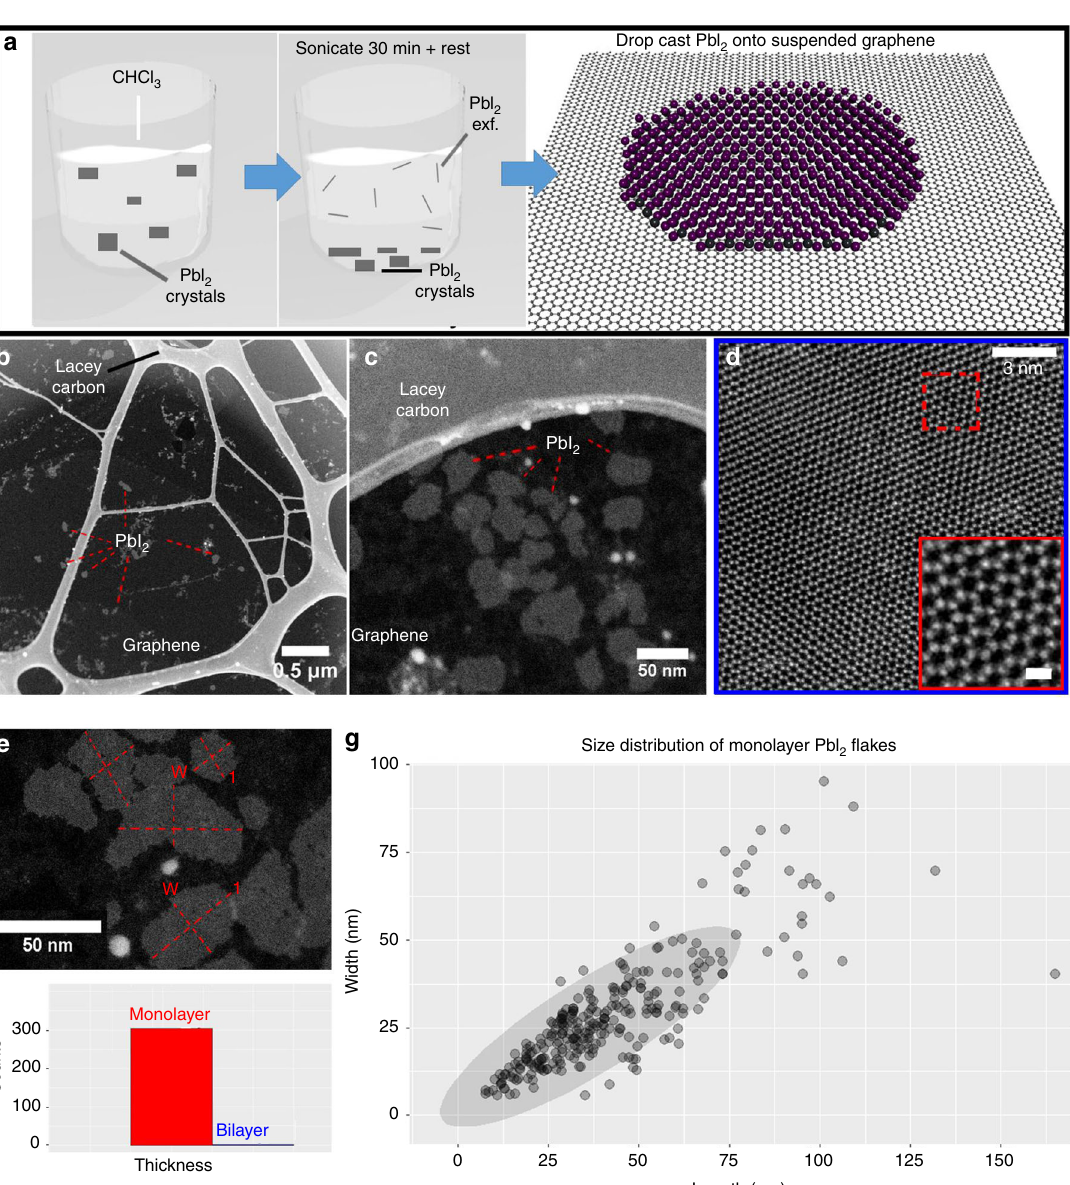
Fig. 1 Schematic diagram for liquid exfoliation and results. a Schematic of the LPE synthesis of monolayer PbI 2 fl akes and deposition on to suspended graphene. b , c ADF-STEM image of monolayer PbI 2 fl akes at different magni fi cations. d Atomic resolution ADF-STEM image of a monolayer PbI 2 fl ake. The inset in the fi gure shows an atomic resolution image of the structure. The scale bar is 0.5 nm. e Typical method for measuring the length(l) and width(w) of the monolayer fl ake. f Histogram showing the thickness distribution of PbI 2 fl akes. g Plot of the size distribution for >300 monolayer fl akes. Overlapping sizes of different fl akes show darker color for their marker dots. The oval represents the highest congregation of fl ake sizes in the overall sample